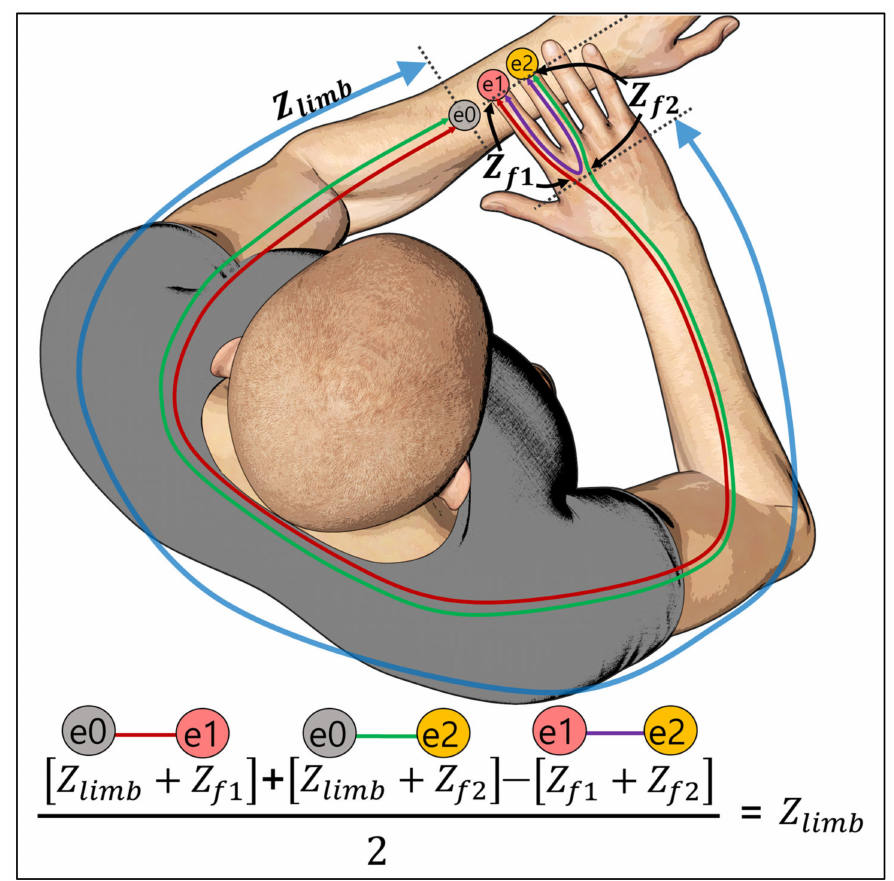
Figure 2. Principle of peripheral variation removal. The pure upper limb impedance can be obtained by subtracting the impedance of a pair of fingers (e.g., ( e 1 , e 2 )) from the sum of the impedances from electrode e 0 (e.g., ( e 0 , e 1 ) + ( e 0 , e 2